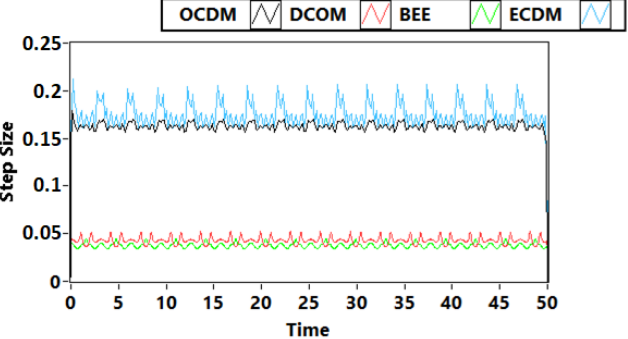
Figure 9. Graphs of step size behavior for different controllers under investigation for two-body